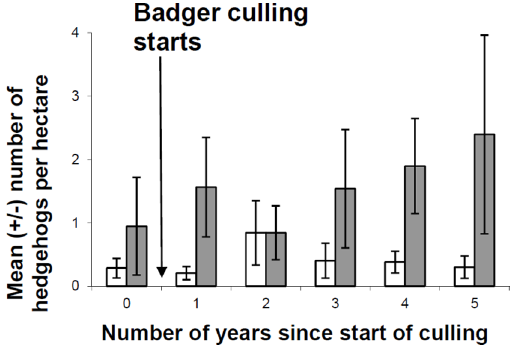
Figure 1. Mean hedgehog density on amenity grassland fields during the Randomised Badger Culling Trial. Shaded columns show badger culling areas and white columns show experimental control